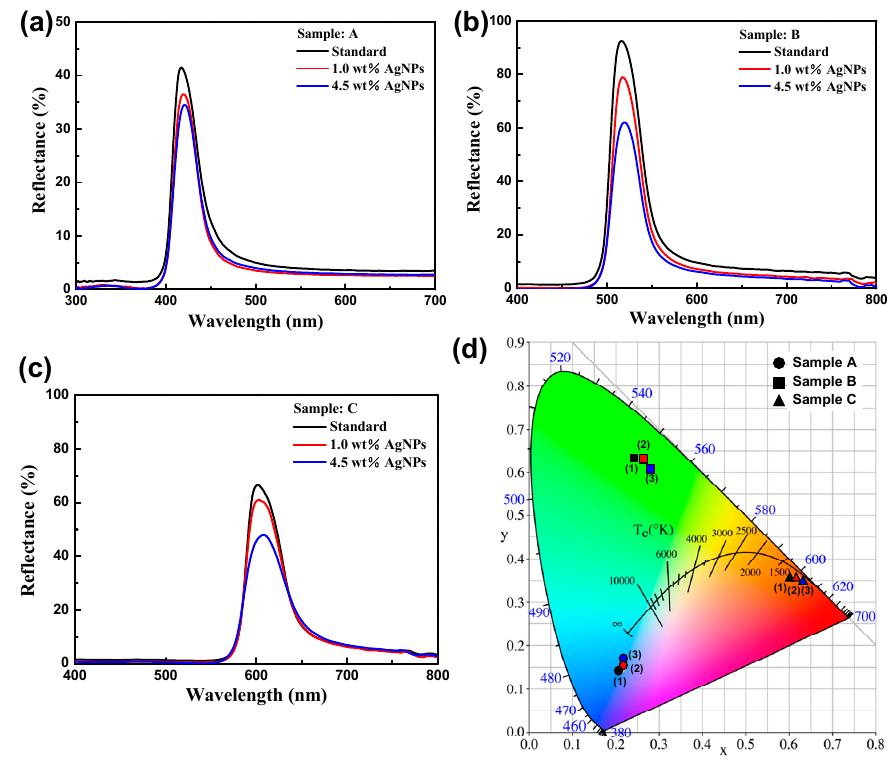
Figure 5. Reflection spectra of PS CPhC films with and without AgNPs: ( a ) sample A ( ● ); ( b ) sample B ( ■ ); and ( c ) sample C ( ▲ ). ( d ) Commission International d’Eclairage (CIE) chromaticity diagram of AgNPs/PS hybrid CPhC color films for different samples (A–C) and AgNPs contents.